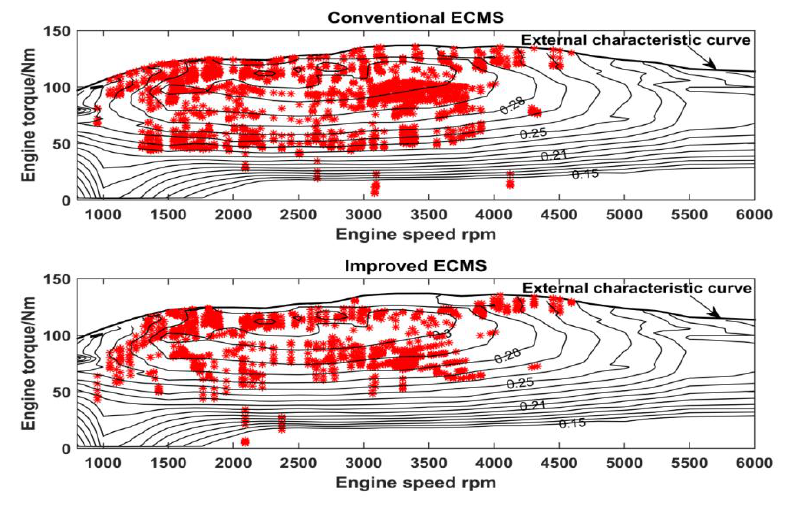
Figure 13. Engine efficiency. Figure 13. Engine e ffi ciency.